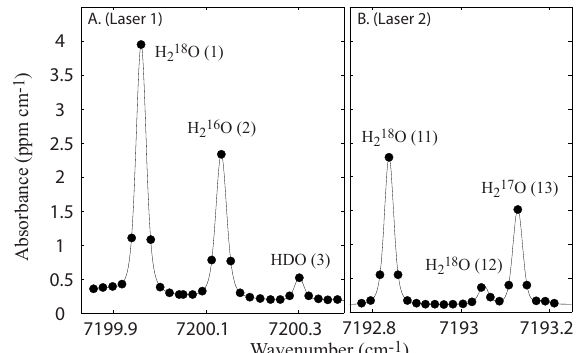
Figure 1. Measured absorption spectrum for water isotopologues in the two wavenumber regions used by the L2130- i -C and L2140- i CRDS analyzers. Filled circles: measured absorption for H 2 O va- por 20mmolmol − 1 in dry air carrier, 66.7hPa cavity pressure. The isotopologue associated with each peak is noted, with nominal peak numbers for reference (1–3 on laser 1, 11–13 on laser 2). Lines: least-squares fit to the data using Galatry profiles as discussed in the